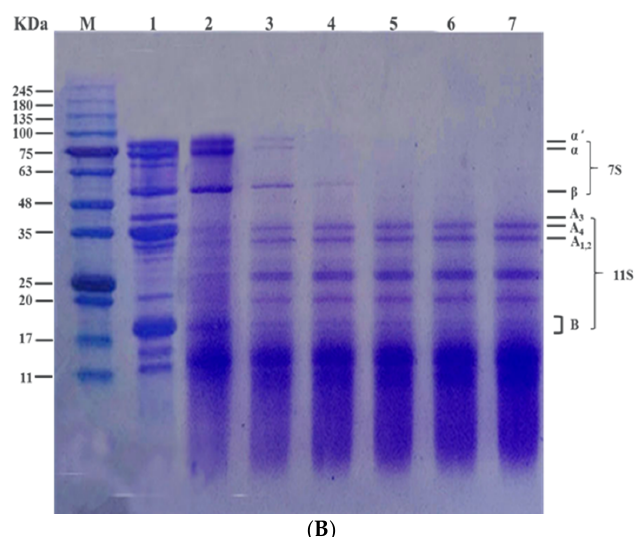
Figure 4. SDS-PAGE electrophoretic profiles of various formulations during the in vitro digestion process. ( A ) M. Standard molecular mass; 1. Electrophoresis is bands for samples without pepsin; 2-7. SPI at different temperatures: untreated SPI and pretreated at 70, 80, 85, 90 and 100 °C for 15 min. ( B ) M. Standard molecular mass; 1. Electrophoresis bands for samples without pepsin; 3–7. SPI at different times: untreated SPI and pretreated for 10, 15, 20, 30 and 60 min at 85 °C.